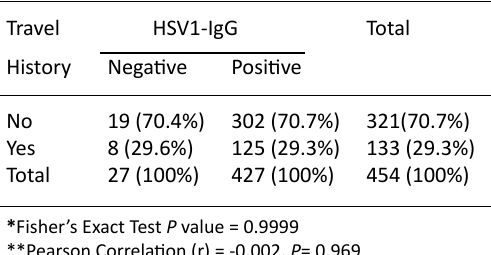
Table 4. HSV-1 Seroprevalences in Iraqi healthy blood donors, grouped according to travel history